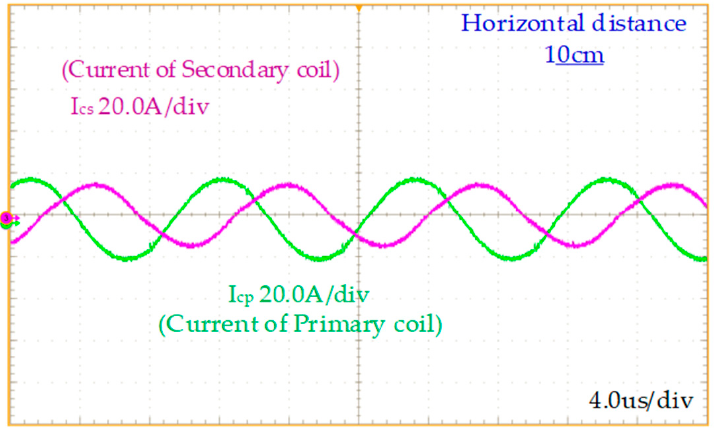
Figure 18. Current waveforms of primary and secondary coils of the 2-coil system (horizontal sepa- ration distance is 15 cm). Table 3 and Figure 19 provide detailed measurements of the e ffi ciency changes ob- served in the two-coil wireless power transmission system manufactured for this study. The results indicate that power transmission e ffi ciency varies signi fi cantly depending on the load and alignment of the coils. Speci fi cally, the e ffi ciency decreases as the load de- creases, and the highest e ffi ciency of 92.9% was observed at the maximum output capacity of 3.3 kW. The measurement results also reveal that the alignment of the coils signi fi cantly im- pacts the e ffi ciency of power transmission. The maximum e ffi ciency of 92.9% was achieved when the coils were well aligned, with the center of the receiving coil positioned near the center of the transmi tt ing coil. When the center of the receiving coil was placed 10 cm away from the center of the transmi tt ing coil, the e ffi ciency only decreased slightly to 92.3%, indicating that the e ffi ciency change was relatively insigni fi cant. However, when the distance between the two coils was increased to 15 cm, the transmission e ffi ciency decreased to 90.9%, and the e ffi ciency dropped exponentially as the horizontal distance increased. These fi ndings highlight the importance of coil alignment in optimizing the e ffi ciency of wireless power transmission systems and suggest that even minor deviations in align- ment can signi fi cantly impact power transfer e ffi ciency.